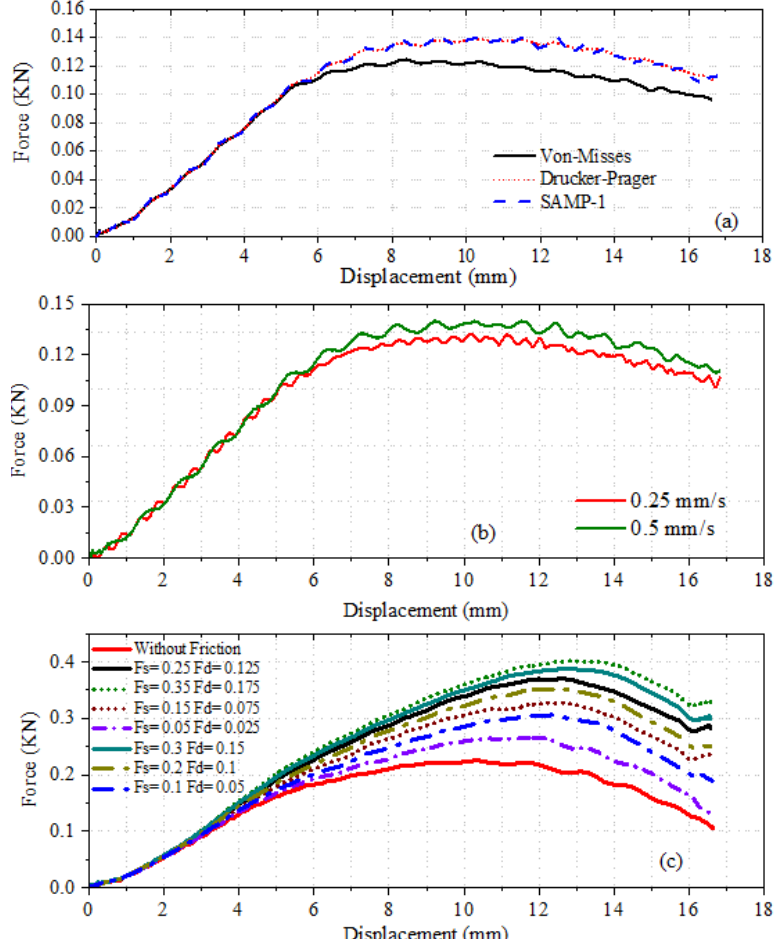
Figure 11. ( a ) Comparative analysis of load–displacement plots considering different yield surfaces in a MAT SAMP-1 material model (deformation rate: 0.5 mm/s); ( b ) Comparison of force–displacement response at different loading rates; ( c ) Effect of static and dynamic contact friction coefficient on the flexural response of short-span beams.